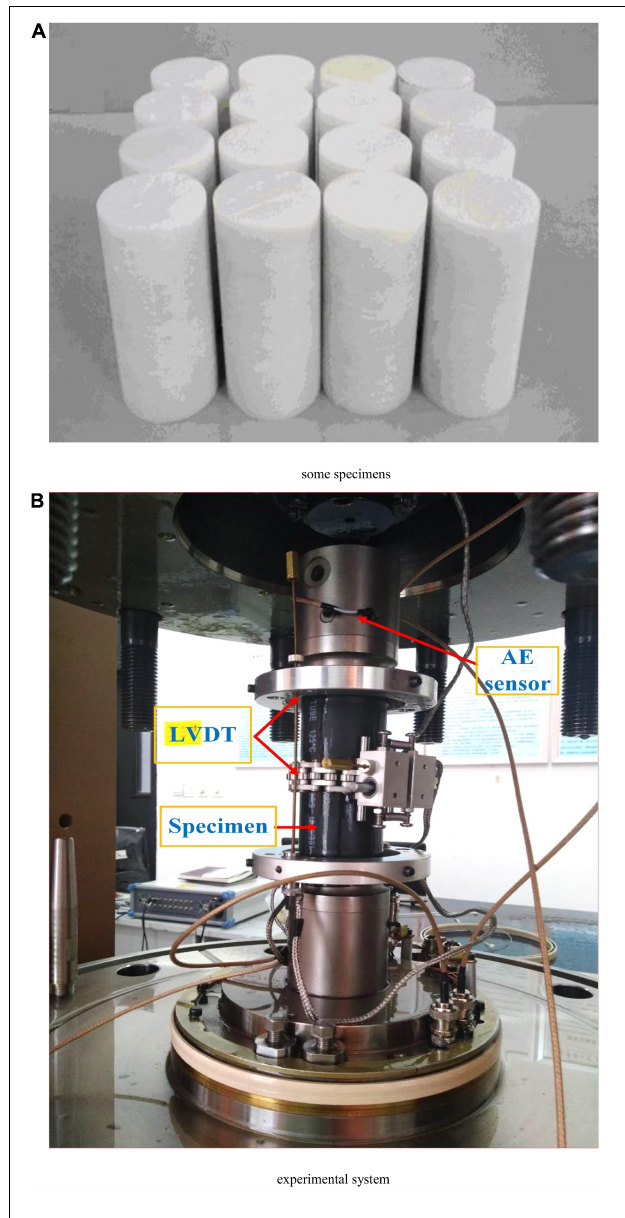
FIGURE 1 | Specimens and system. (A) Some specimens. (B) Experimental